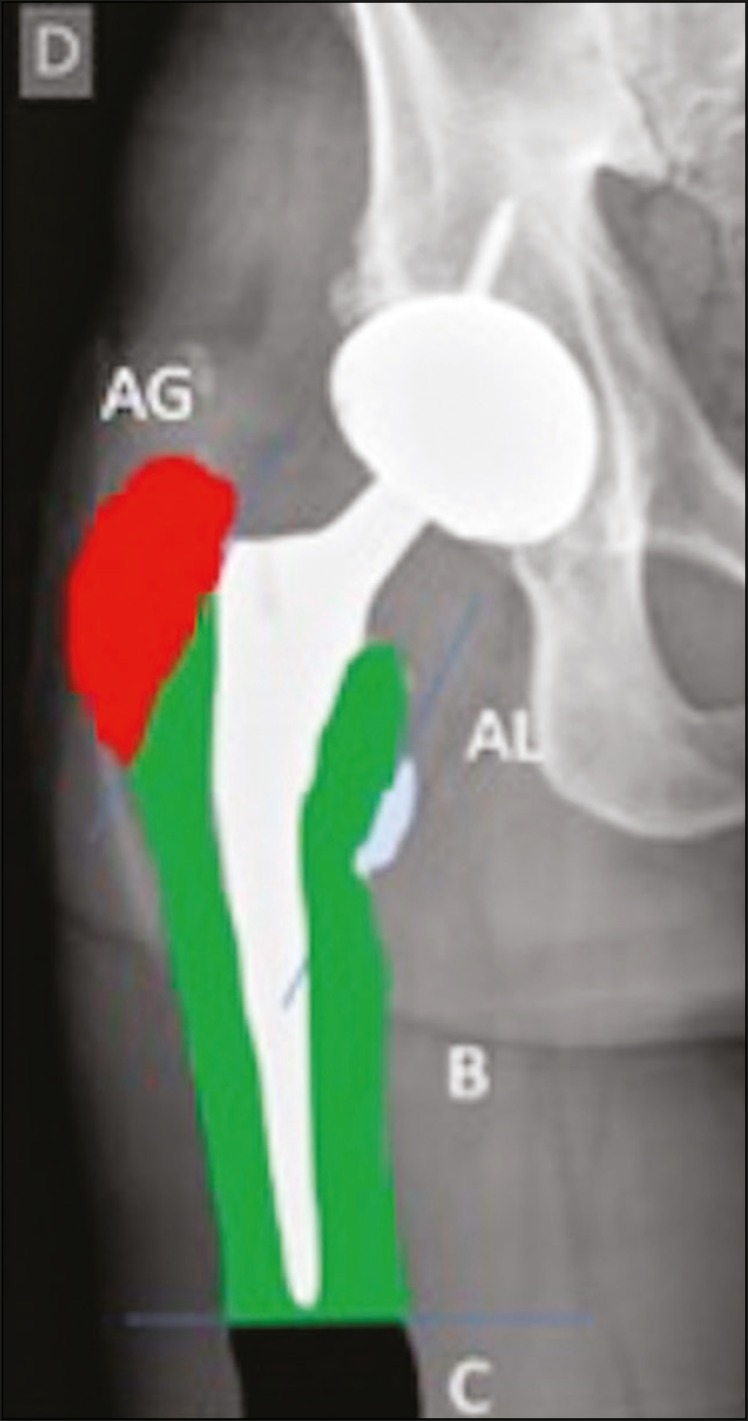
Vancouver classification for periprosthetic fractures.